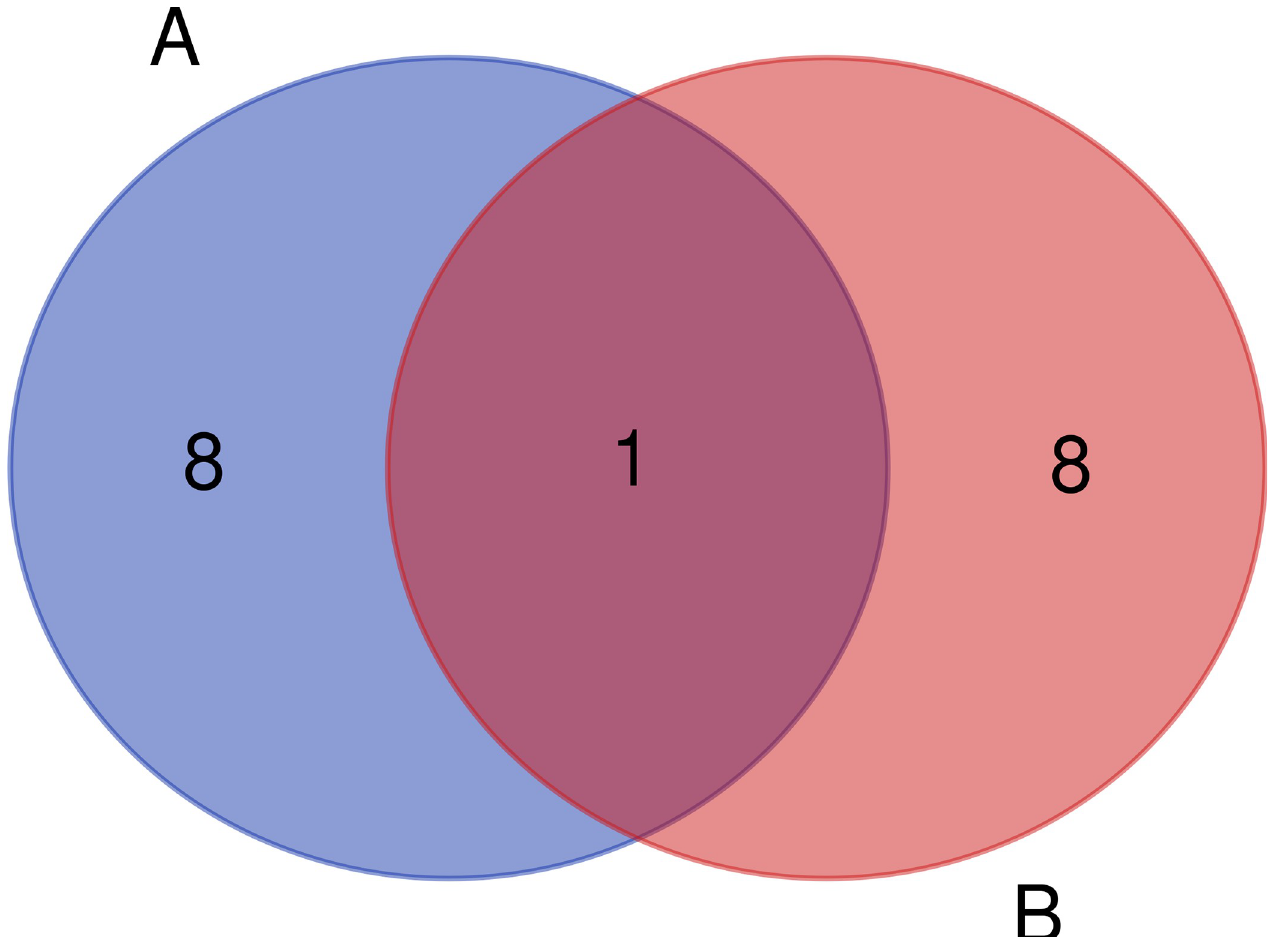
Fig 12. Venn diagram of GO/KEGG enrichment analysis. A: The genes marked by the red box are all enriched to 3 GO terms. B: The gene enriched to � 3 signal pathways is marked by the red frame. https://doi.org/10.1371/journal.pone.0243507.g012 associated protein LRP-5 and LRP-6 co-receptors, and FZD receptors, leading to the activation of disheveled (DSH) and inhibition of the β -catenin degradation complex to stabilize the cyto- plasm. β -catenin then accumulates in the cytoplasm, enters the nucleus, and activates Wnt- regulated targets through interaction with T cell factor (TCF) family transcription factors, with subsequent recruitment of co-activator genes [40]. In the non-classical Wnt/ β -catenin signal- ing, knypek (a member of the glypican family of heparan sulfate proteoglycans) enhances the binding of Wnt to the FZD receptor [47], without involvement of LRP5 and LRP6. DSH is activated by non-classical Wnt signaling via a different protein domain from the classical Wnt/ β -catenin signaling domain [48]. Non-classical Wnt signaling does not need β -catenin or Lym- phoid Enhancer Factor/T-Cell Factor, and in contrast, DSH is activated by the bridging mole- cule Daam1 [49]. Activated DSH can cause calcium flux and activation of calcium-sensitive kinase, protein kinase C, and calcium/calmodulin-dependent protein kinase II [50, 51]. How- ever, it is unclear if Rho1 activation and calcium flux activation occur in the same pathway or in different branches of the non-classical FZD-DSH pathway [52]. In some cases, non-classical Wnt signaling can be blocked by the Wnt/ β -catenin pathway.